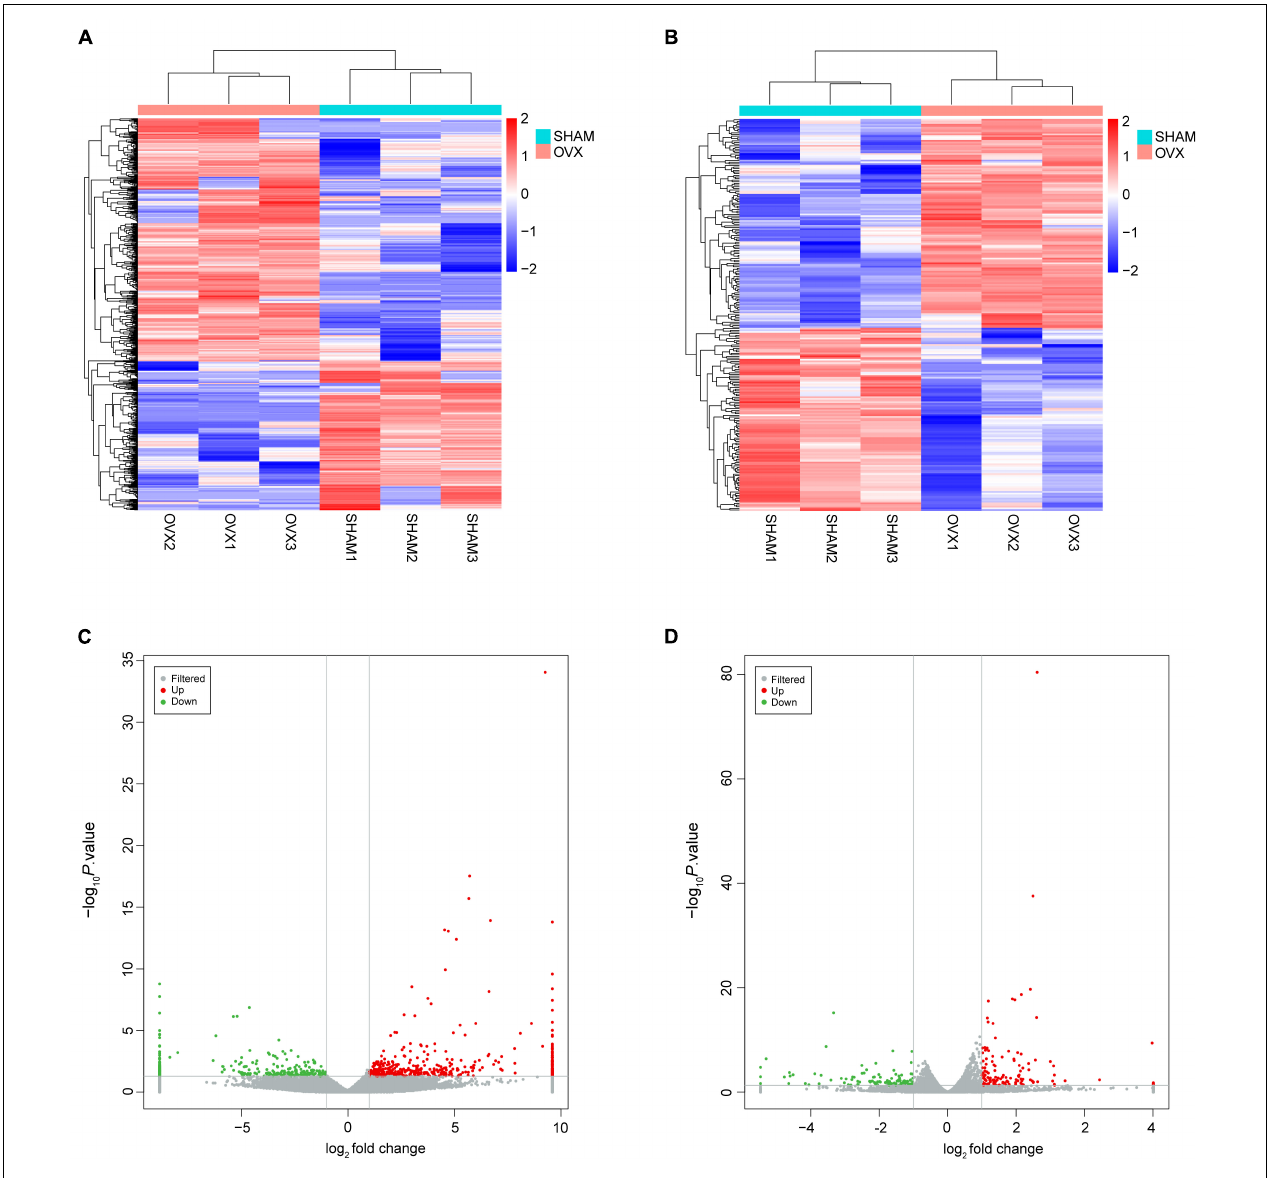
FIGURE 2 | Expression profiles of lncRNAs and mRNAs. (A) Cluster analysis of differentially expressed lncRNAs. (B) Cluster analysis of differentially expressed mRNAs. Red indicates increased expression, and blue denotes decreased expression. (C) The volcano plot of differentially expressed lncRNAs. (D) The volcano plot of differentially expressed